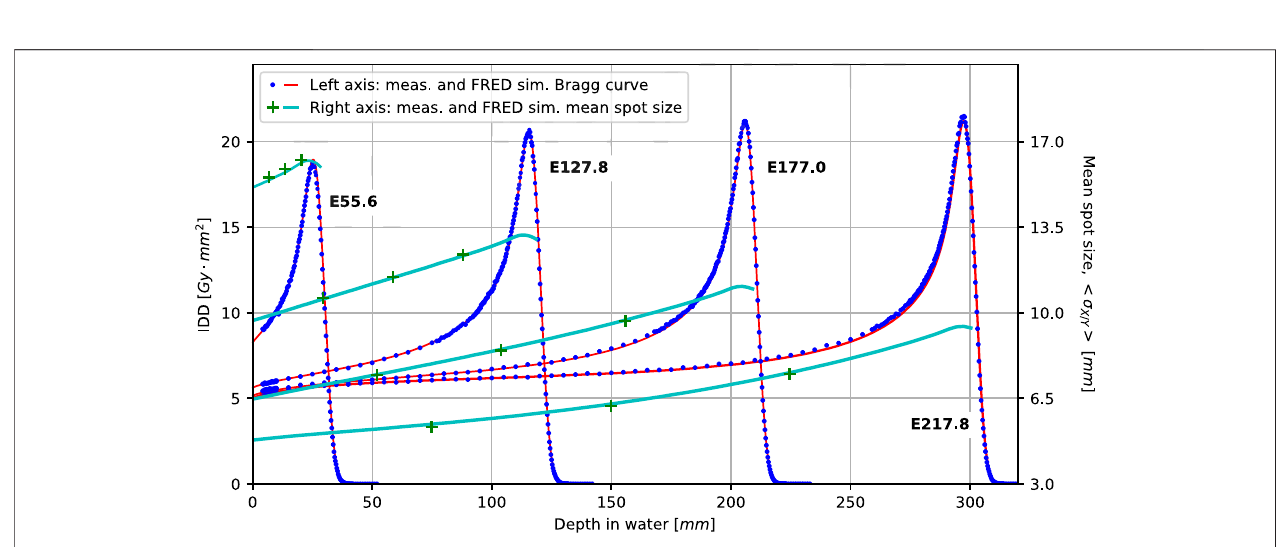
FIGURE5| Comparisonofsimulated(solidlines)andmeasuredBPs(dots)andspotsizes(crosses)inwaterforfourmainnominalenergies(inMeV):E55.6,E127.8, E177.0, and E217.8. All the simulated Bragg curves account for the geometrical acceptance of the Bragg peak chamber detector.